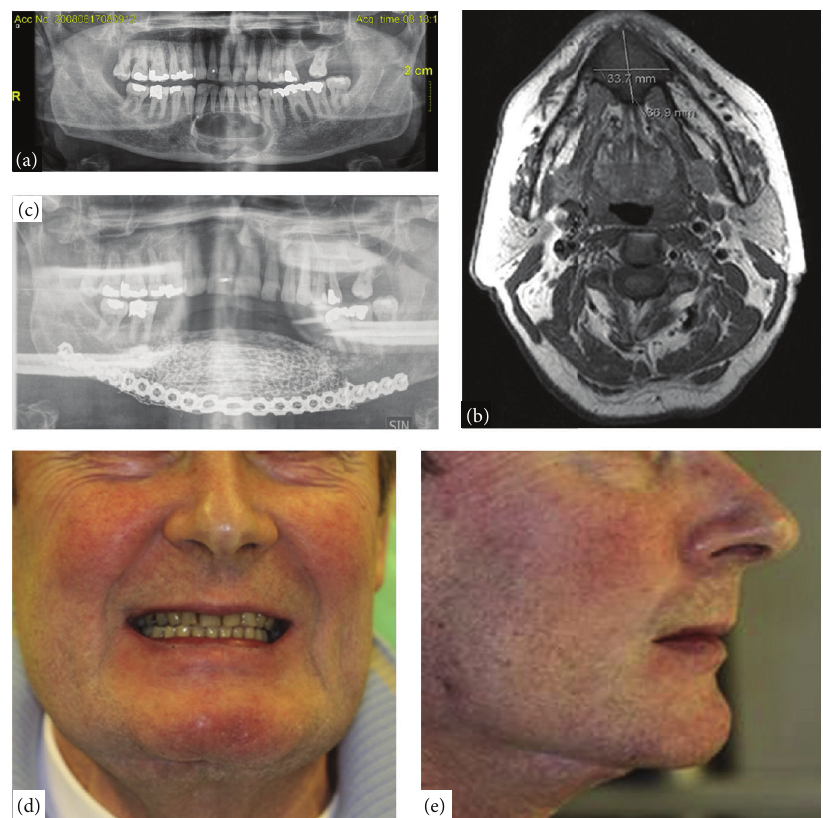
Figure 5: Tissue-engineered ASCs could be utilized to treat a large anterior mandibular defect. (a) X-ray image shows a nearly 10 cm recurrence of an ameloblastoma in the parasymphyseal area of the anterior mandible. (b) T1-weighted magnetic resonance image shows a large tumor (ameloblastoma) in the anterior mandible. (c) X-ray image shows the six implant fixtures inserted into the grafted site. (d) The reconstructed chin taken from the front. (e) The reconstructed chin taken from the lateral side (adopted from